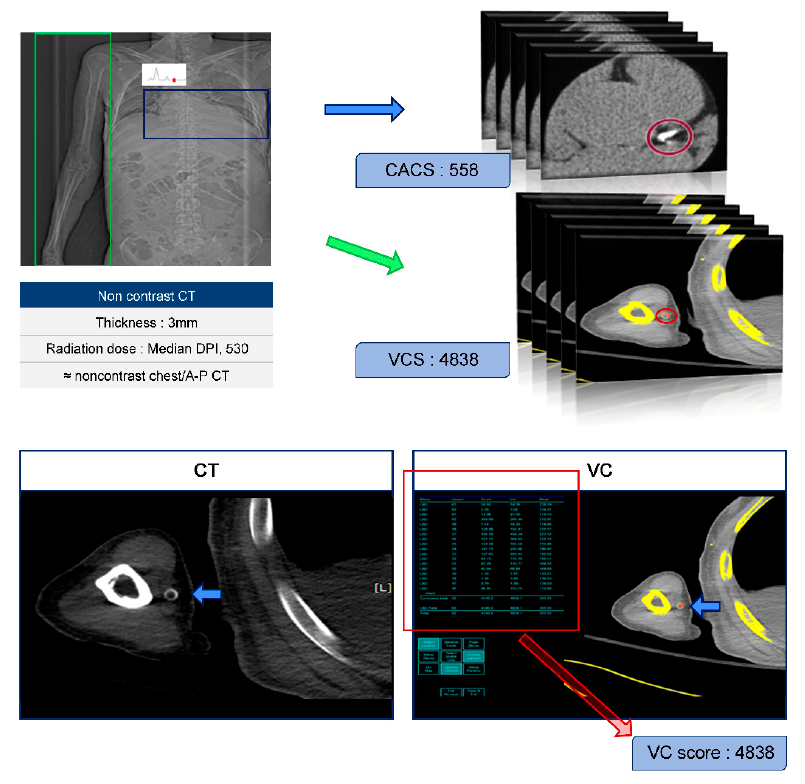
Figure 1. How to calculate the vascular calcification score (VCS).